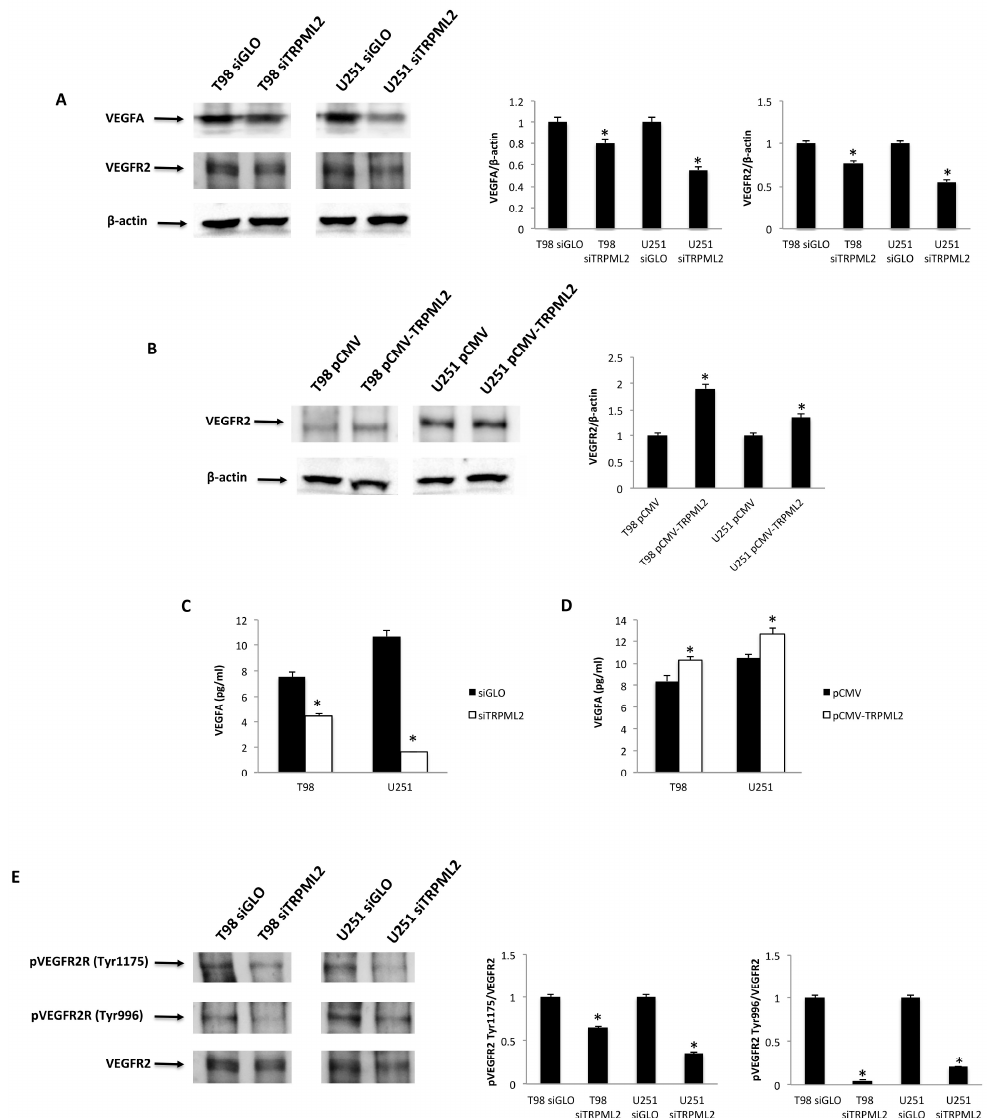
Figure 1. TRPML2 levels influenceVEGFR2 and VEGFA protein levels, as well as VEGFA release in T98 and U251 cell line. ( A ) Representative immunoblots reflecting VEGFA and VEGFR2 protein levels in siGLO and siTRPML2 T98 and U251 cell lines. Blots are representative of one of three separate experiments. Densitometry values were normalized to β -actin, which was used as a loading control. Data of siGLO vs. siTRPML2 T98 and U251 cell lines are expressed as the mean ± SE of three separate experiments. * p < 0.05. ( B ) Representative immunoblots reflecting VEGFR2 protein levels in pCMV and pCMV-TRPML2 T98 and U251 cell lines. Blots are representative of one of three separate experiments. Densitometry values were normalized to β -actin, which was used as a loading control. Data of pCMV vs. pCMV-TRPML2 T98 and U251 cell lines are expressed as the mean ± SE of three separate experiments. * p < 0.05. ( C , D ) Levels of VEGFA release measured by ELISA were evaluated at 24 in siGLO and siTRPML2 and pCMV and pCMV-TRPML2 T98 and U251 cell lines. Data are expressed as the mean ± SE of three separate experiments. * p < 0.05. ( E ) Representative immunoblots reflecting the activated pVEGFR2(Tyr1175) and pVEGFR2(Tyr996) protein levels in siGLO and siTRPML2 T98 and U251 cell lines. Blots are representative of one of three separate experiments. Densitometry values were normalized to VEGFR2 total levels. Data are expressed as the mean ± SE of three separate experiments. * p < 0.05.